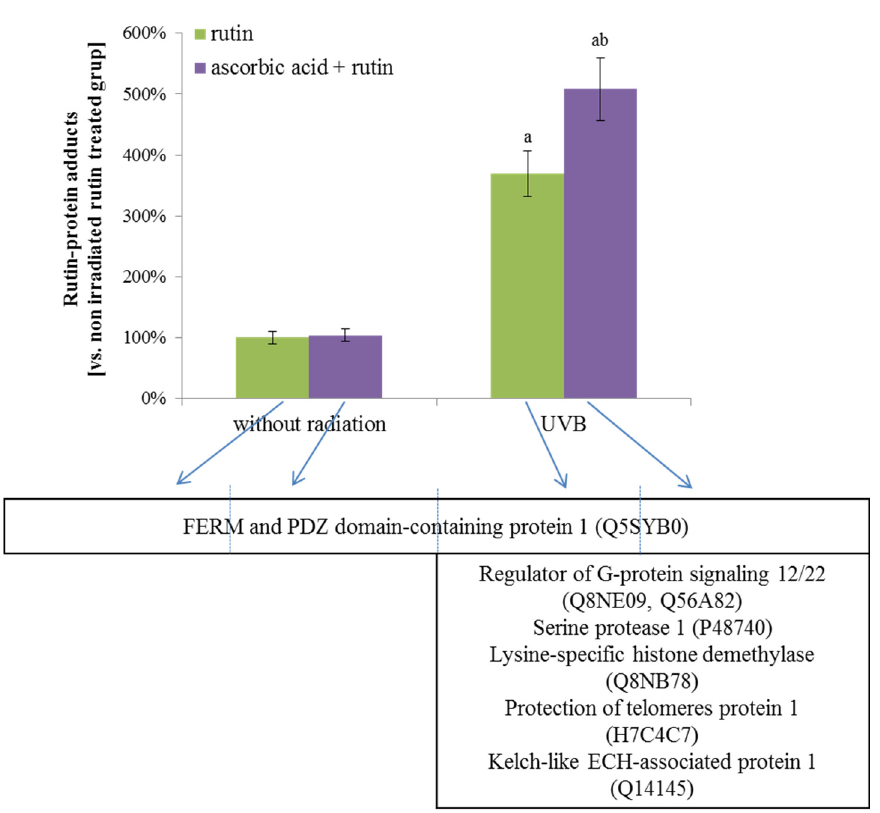
Figure 5. The level of rutin-protein adducts and the names of these proteins in 3D cultured fibroblasts treated with rutin [25 μ M] and/or ascorbic acid [100 μ M], and exposed to UVB irradiation (200 mJ/cm 2 ). Analyses were made based on label free quantification. Mean values ± SD of three independent experiments are presented. a statistically significant differences vs. non-irradiated group, p < 0.05; b statistically significant differences vs. rutin treated group exposed to the UVB irradiation, p < 0.05.